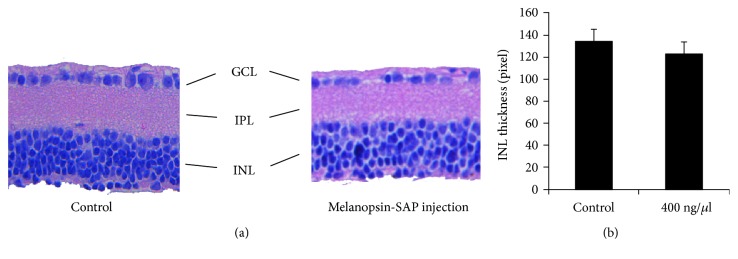
The morphological examination of retinal sections after injection of melanopsin-SAP immunotoxin in rd mice. (a) Photomicrographs of 8 μm paraffin sections of retina were used for H&E staining. No significant morphological differences were observed between the highest dose group and the control group. Bar = 100 μm. (IPL = inner plexiform layer; INL = inner nucleus layer; GCL = ganglion cell layer). (b) The thickness of the INL was measured using IPP software (pixel). The difference in the INL thickness between the highest dose group and the control group was not statistically significant (independent sample t-test, P > 0.05).